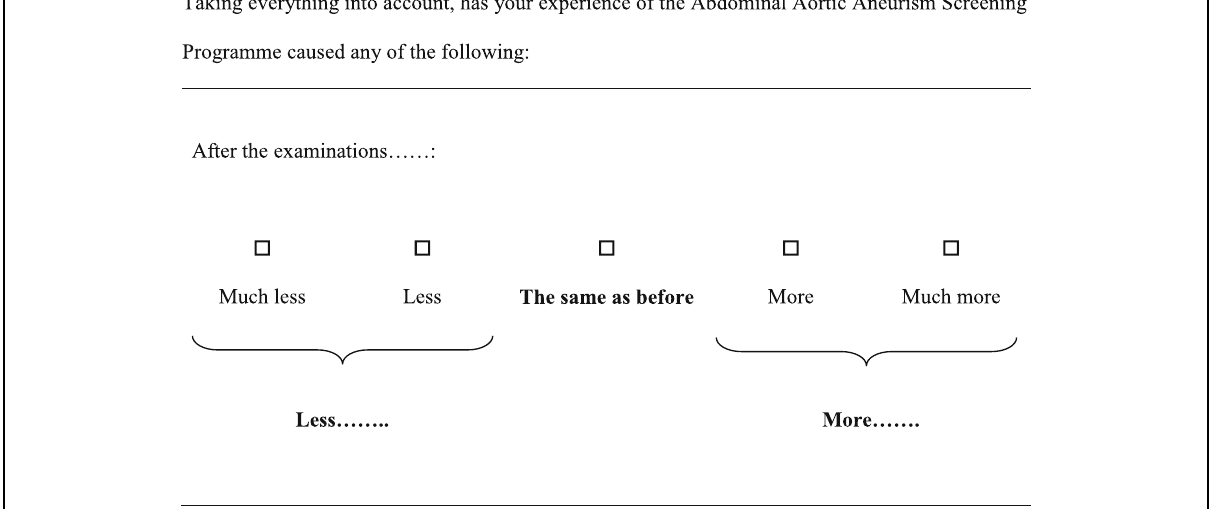
Fig. 2 The layout and response categories for part II of the Consequences of Screening